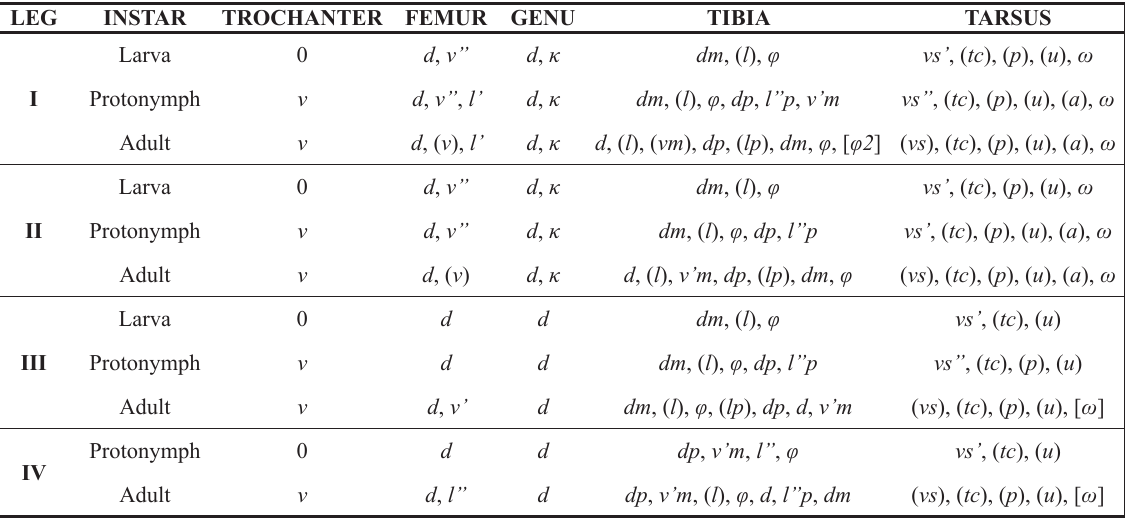
Table 2. Setal leg ontogeny of Neophyllobius cibyci sp. nov., parentheses represent a setal pair and square brackets indicate additional setae in